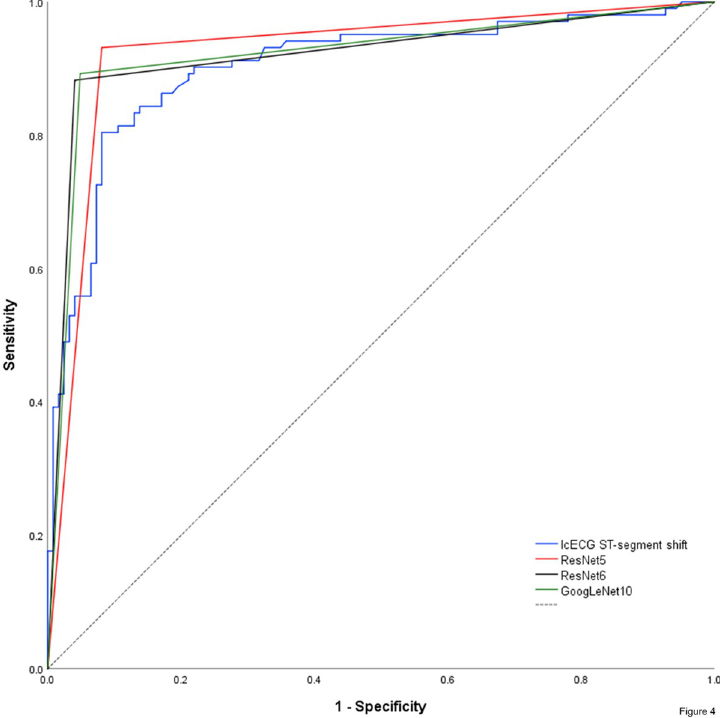
Fig 4. Nonparametric receiver–operating characteristic curve of the icECG ST–segment shift and the network predictions using coronary artery patency or occlusion as dichotomic reference for absent or present myocardial ischemia. Of note, network prediction provides a dichotomous output (non–ischemic respectively ischemic), resulting in a triangular ROC–curve. Hence, there is only one combination of sensitivity and specificity possible for each CNN. Dashed black line = reference